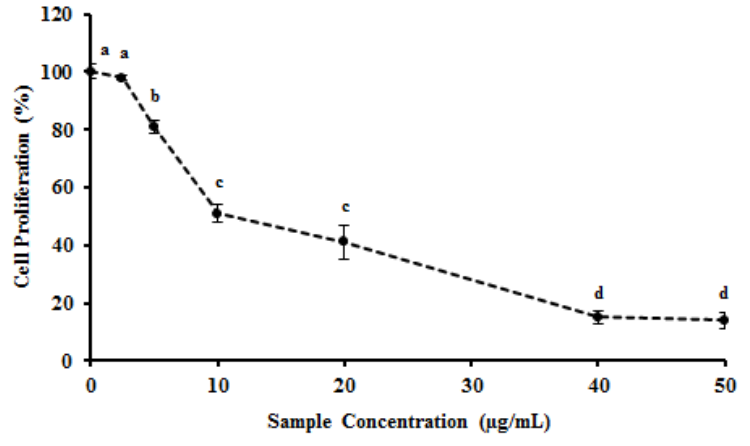
Figure 5. Effect of MEC on HeLa cell proliferation measured by MTT test. HeLa cells proliferation was carry out in the presence or absence of MEC (0; 2.5; 5.0; 10; 20; 40; 50 µg/mL). Letters a,b,c,d Indicate significantly differences between different concentrations of the same sample. Student-Newman-Keuls test ( p <